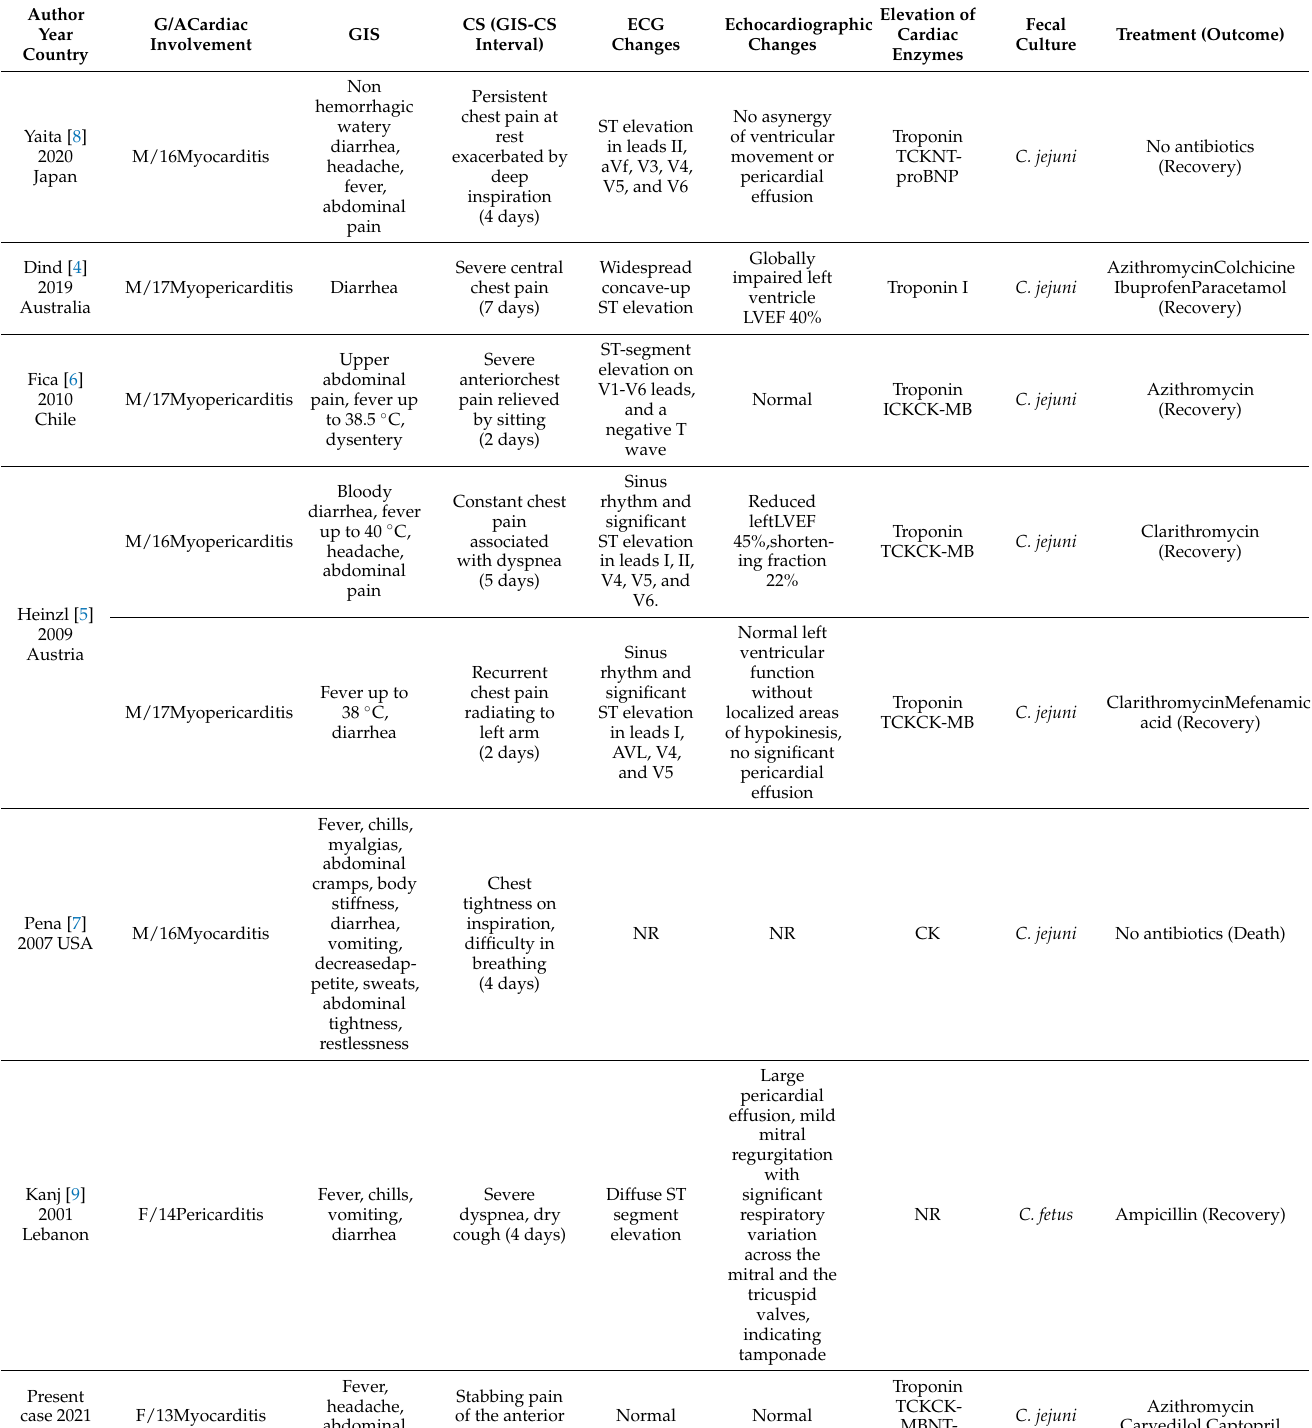
Table 3. Summary of the cases reported in the